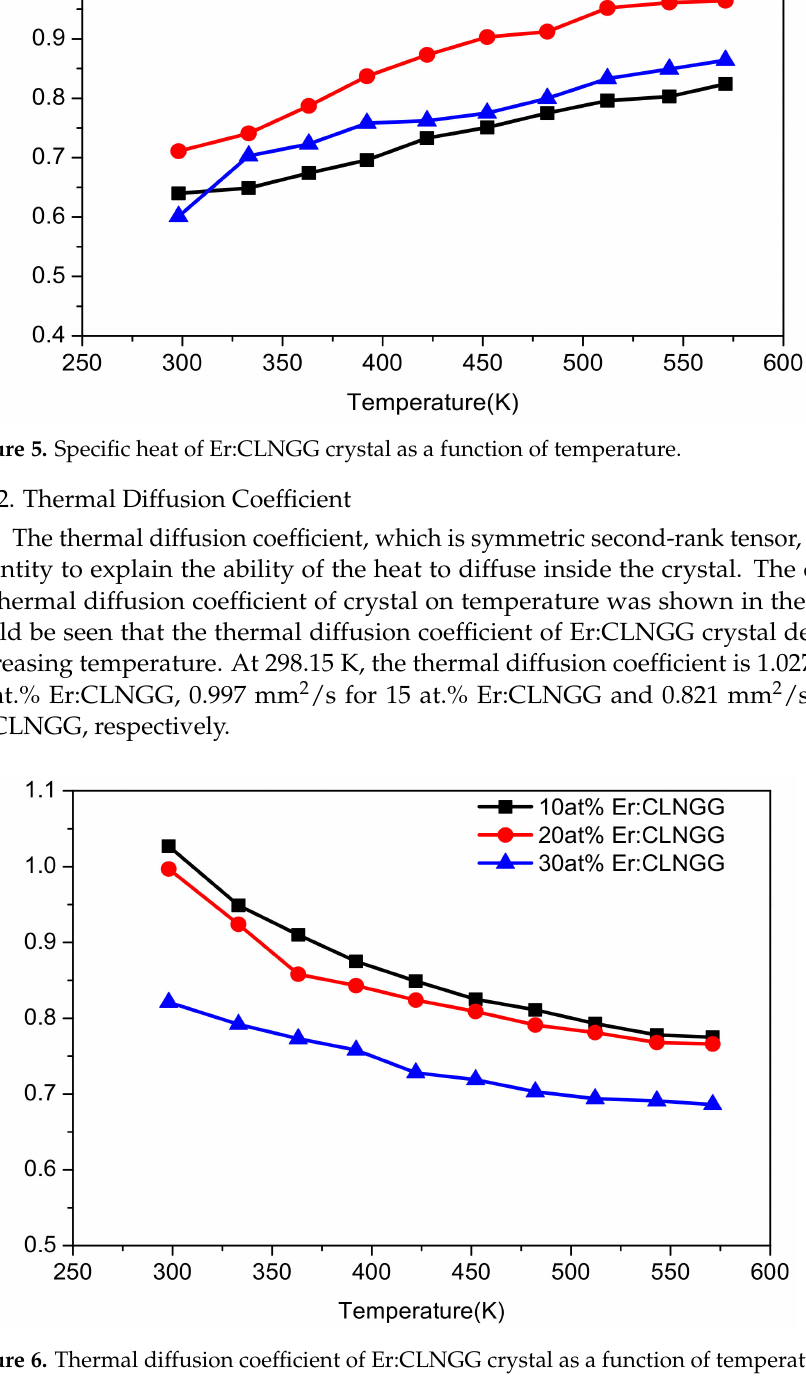
Figure 6. Thermal diffusion coefficient of Er:CLNGG crystal as a function of